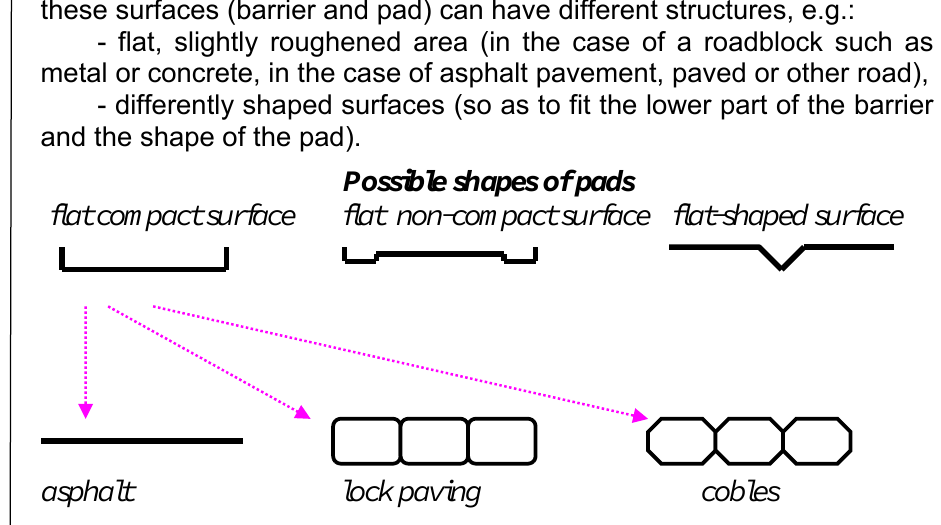
Figure 7 – Interaction of the interlocking surfaces of the barrier and pads Рис . 7 – Взаимодействие нижней части барьера с основанием Слика 7 – Интеракција доњих површина баријере и